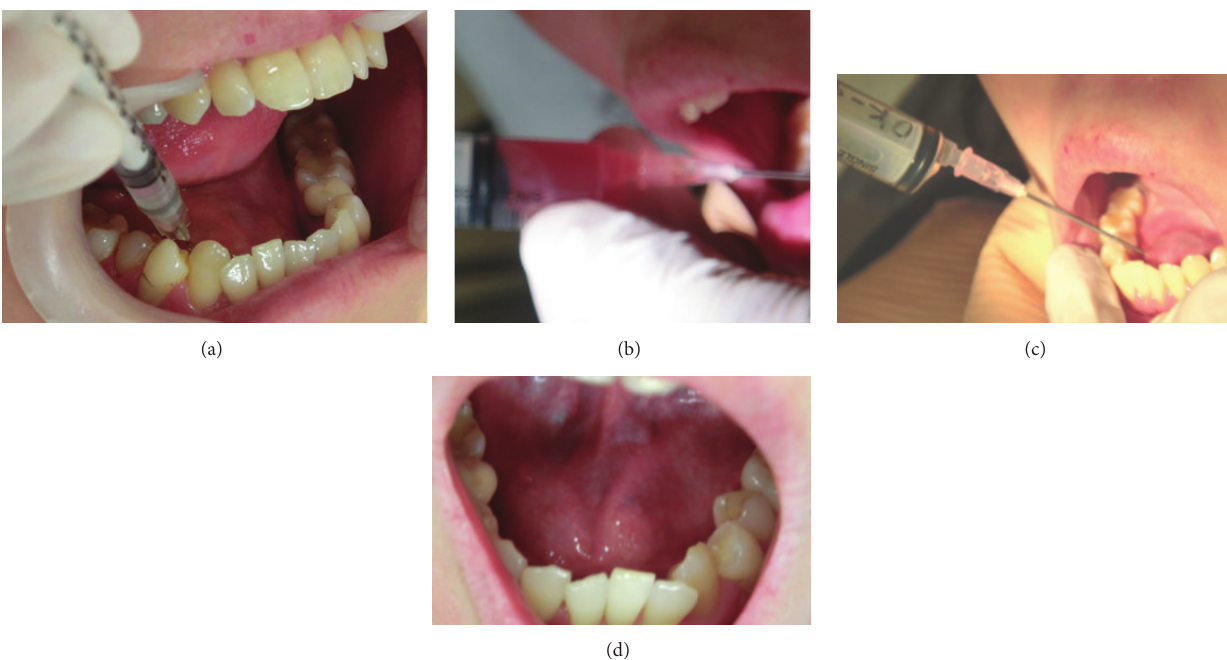
Figure 4: Procedure of first local injection of OK-432 solution (0.7 KE/0.3 mL) using a 27-G needle (a). The cyst showed no inflammation after the first procedure. Nine consecutive days later, we punctured the cyst using an 18 G needle, and the maximum possible amount of mucus (10mL) was aspirated immediately (b). OK-432 solution (0.2 Klinische Einheit [KE] per millimeter; total 1KE/5 mL) was then injected using the same needle (c). There was mild spontaneous pain and swelling with redness around the injected region over the center-line of the mouse at eight days after the second injection of OK432 (1KE/5 mL) (d).